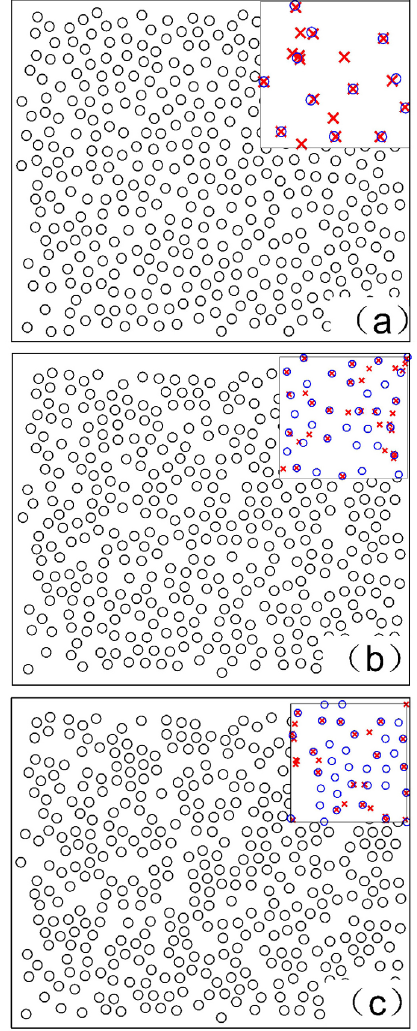
Fig. 6 Coordinates of colloidal particles corresponding to (a) = 10 A , (b) 500, and (c) 1000. The insets of (a), (b), and (c) show e the snapshots of (a), (b), and (c), respectively, with the substrate pinning centers denoted by crosses.